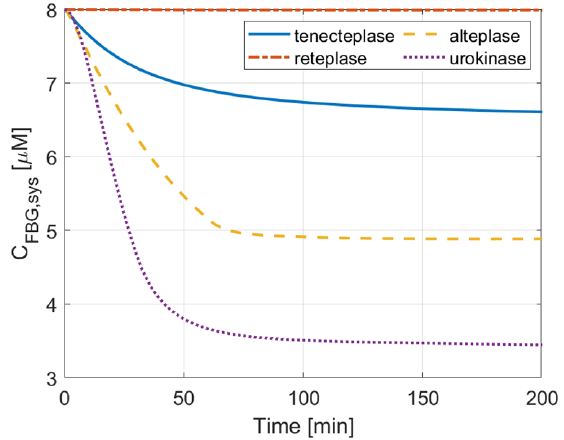
Figure 5. Comparison of fibrinogen concentration in systemic plasma. FBG concentration in the plasma (lower concentration represents higher ICH risk): urokinase < alteplase < tenecteplase < reteplase.